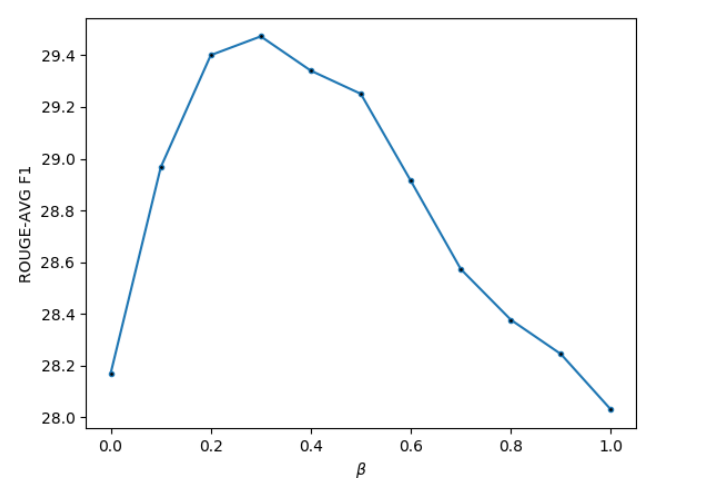
Figure 3. The change of Recall-Oriented Understudy for Gisting Evaluation (ROUGE)-AVG F1-score according to the β on the validation set.